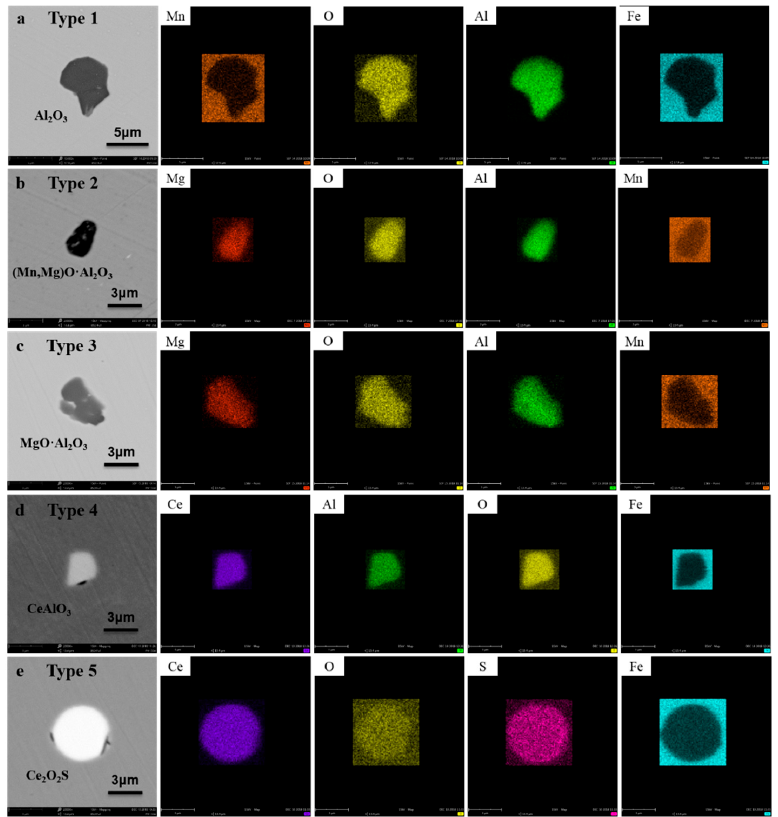
Figure 2. Elemental mapping of typical inclusions in steel: ( a ) Al 2 O 3 ; ( b ) (Mn,Mg)O · Al 2 O 3 ; ( c ) MgO · Al 2 O 3 ; ( d ) CeAlO 3 ; ( e ) Ce 2 O 2